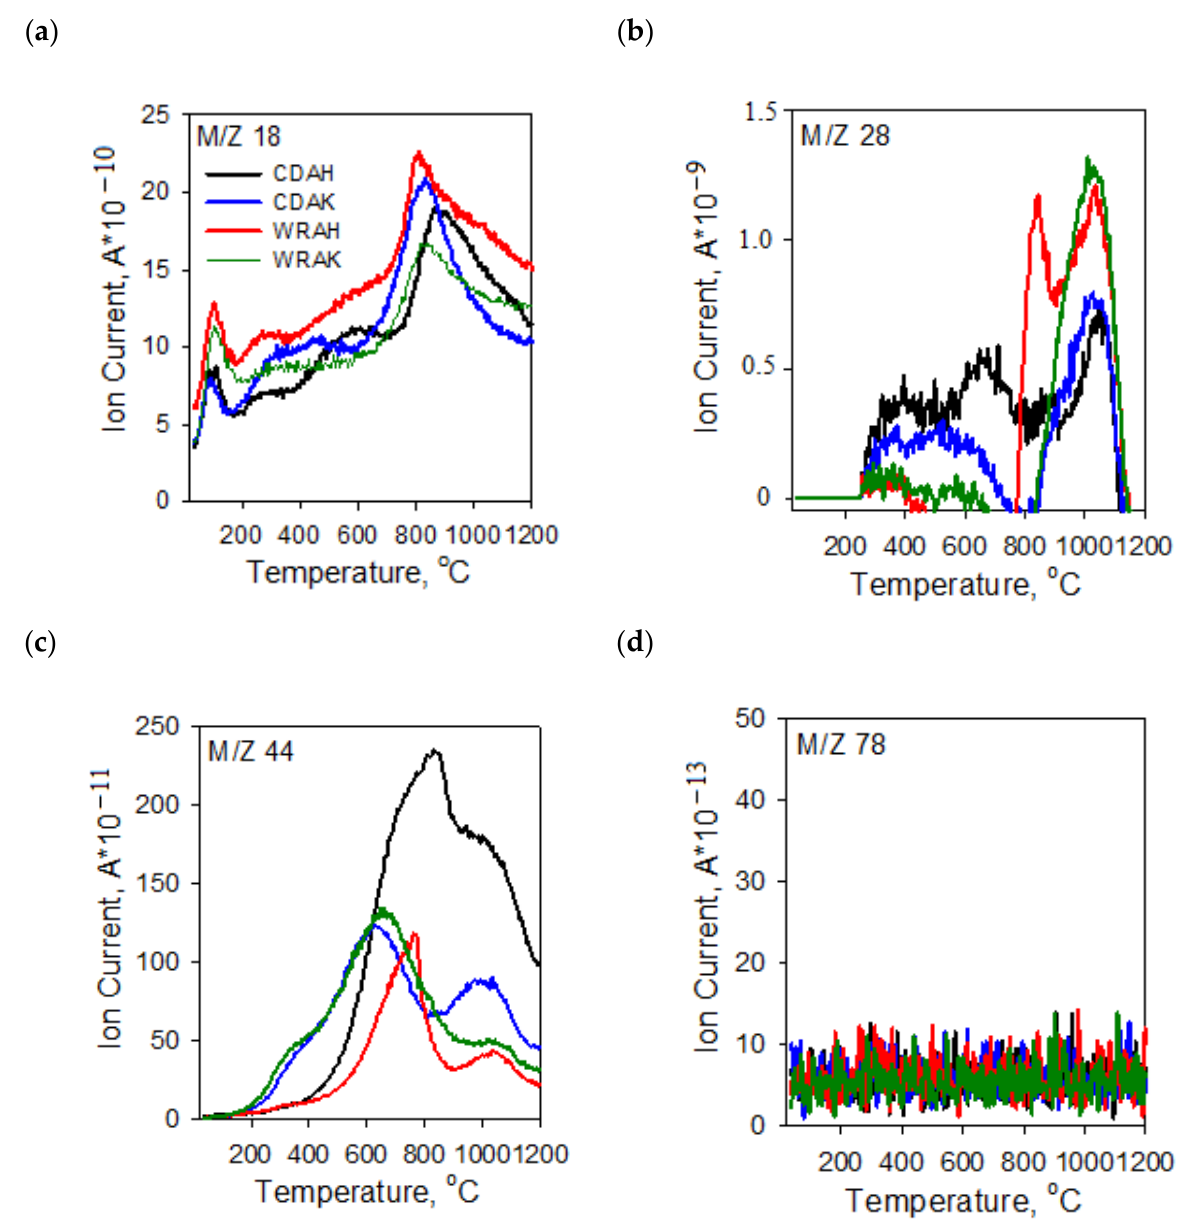
Figure 4. TG ( a ) and DTG ( b ) curves of the activated carbons obtained in the helium atmosphere.